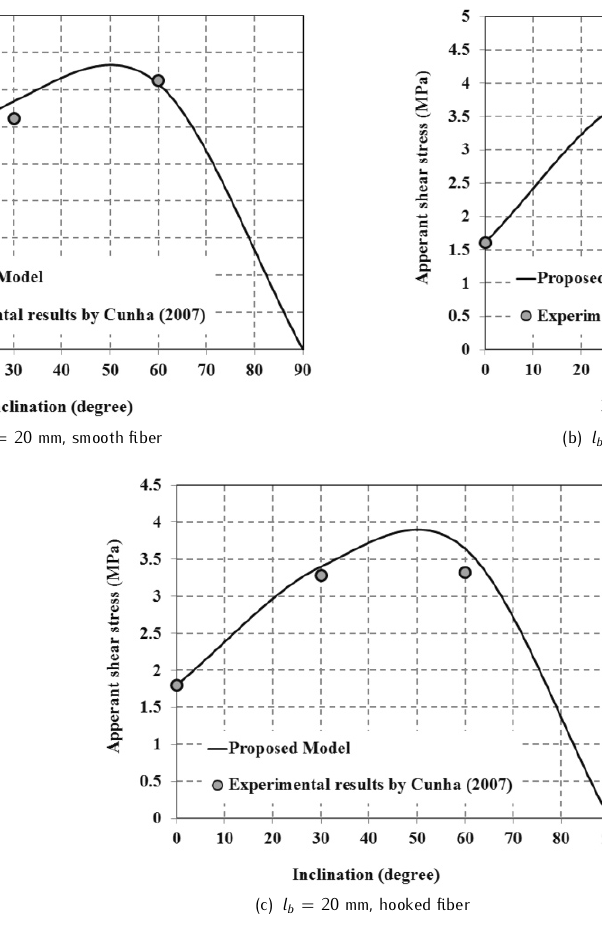
Figure 9. Comparison of the proposed apparent shear strengths (Equation (7)) with shear strengths obtained by using the Cunha [29] experimental results subjected to calibration according to inclination angle by using Equations (2)–(11) in Figure 2.